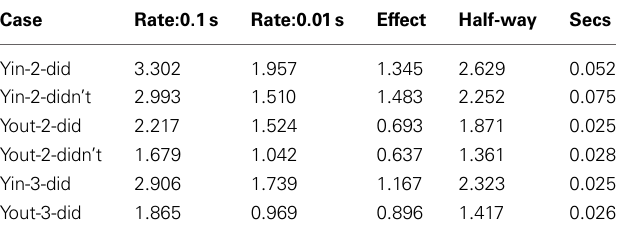
Table 2 | Estimates of the time in secs to reach 50% of the illusion as rated at